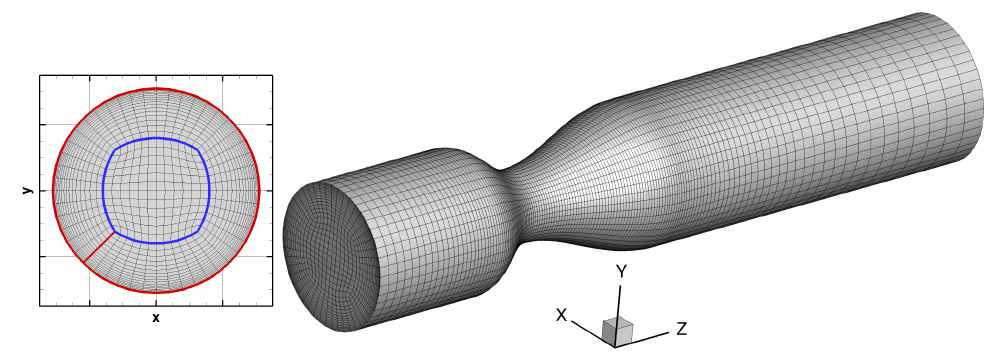
Figure 10. Computational mesh—multiblock structure and